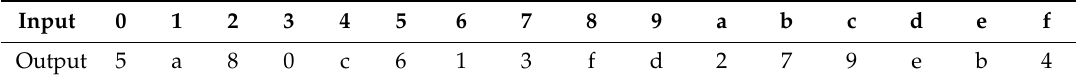
Table 3. Inverse S-box